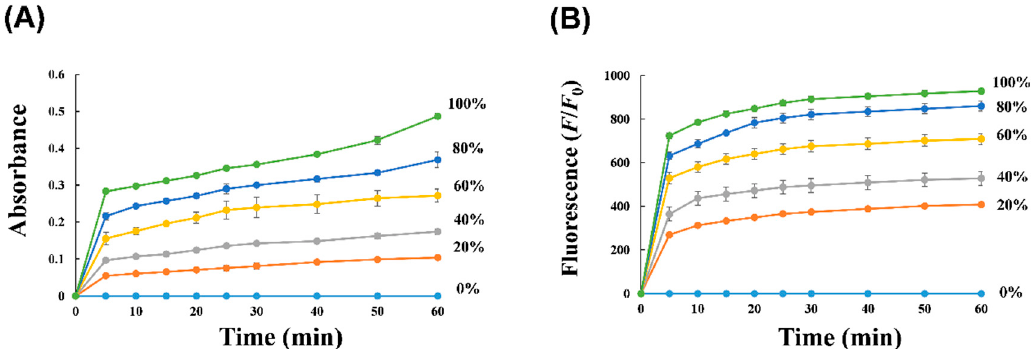
Figure 4. Time-dependent signal generation from sequential DNAzymes at different concentrations of artificial tears. The absorbance was obtained at 650 nm using colorimetric substrate ( A ) and the fluorescence signal was at excitation/emission wavelengths of 560 nm/580 nm using fluorogenic substrate ( B ), which monitored every 5 min for 1 h.